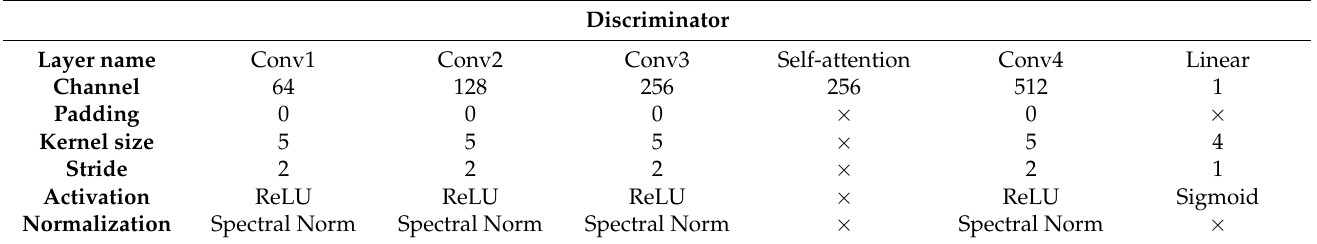
Table 3. The structure and parameters of the discriminator.